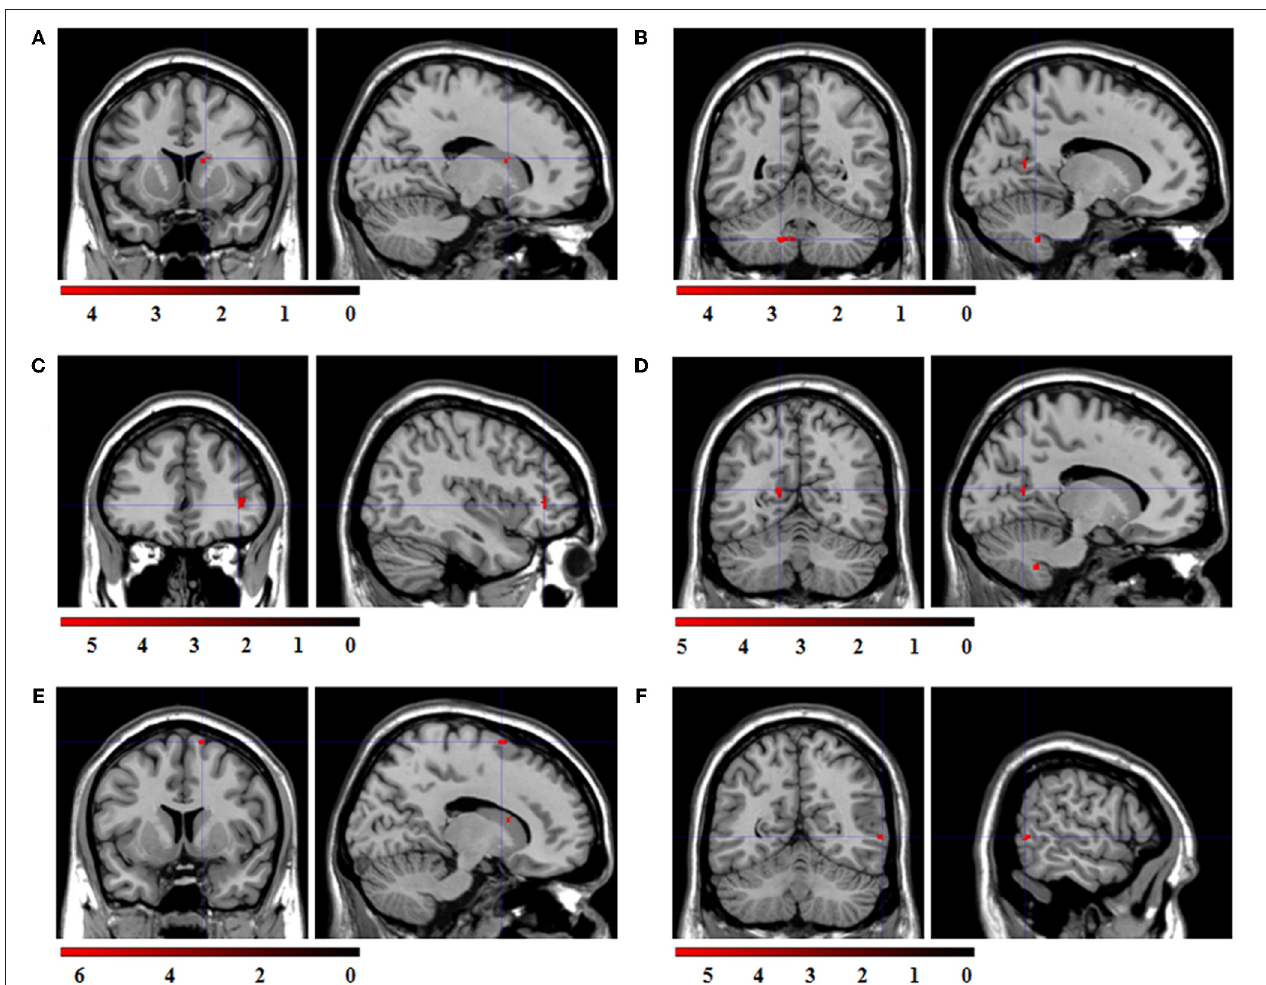
k = 29 voxel). (C) Significant co-activation in the right inferior frontal gyrus, ( x = 40, y = 38, z = 2; t = 5 . 82; k = 18 voxel). (D) Significant co-activation in the left posterior cingulate cortex, ( x = − 14, y = − 60, z = 14; t = 5 . 03; k = 6 voxel). (E) Significant co-activation in the right supplementary motor area, ( x = 14, y = 8, z = 70; t = 6 . 27; k = 6 voxel). (F) Significant co-activation in the right middle temporal cortex, ( x = 60, y = − 58, z = 2; t = 5 . 44; k = 5